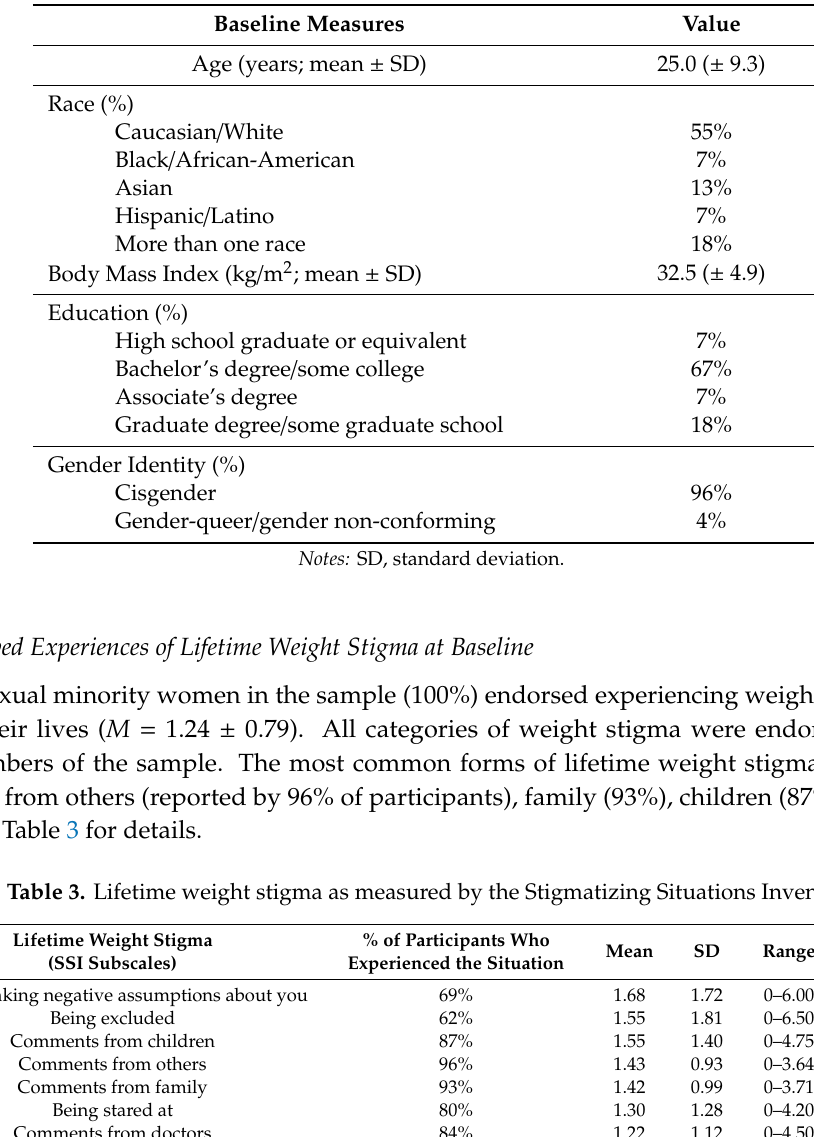
Table 2. Participant Characteristics.